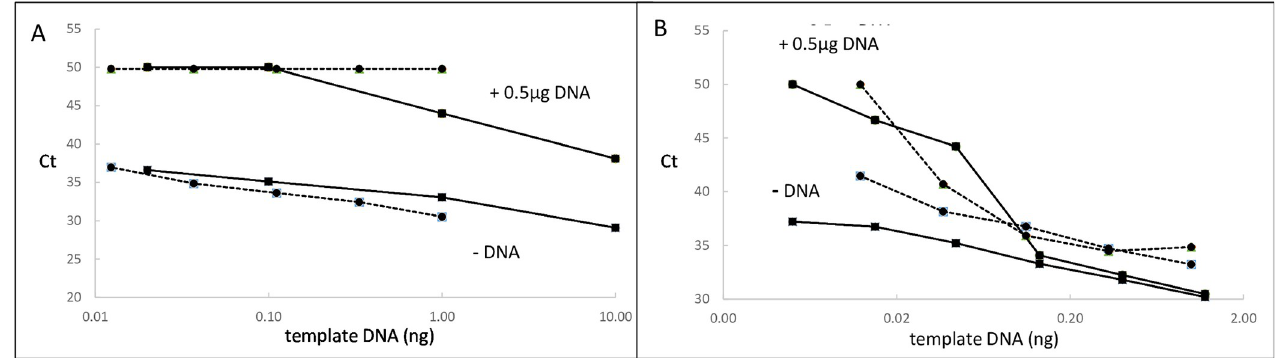
Fig 1. Inhibition of the PCR by genomic DNA. The primers were amplifying their target sequence in various masses of template DNA. An additional 0.5 μ g of non-leukemic genomic DNA was or was not added to each well. In each panel, the 2 solid lines refer to one patient and the 2 broken lines refer to another patient. Panel A shows 2 examples of severe inhibition and panel B shows 2 examples of mild inhibition. A Ct of 50 indicates that the PCR failed and no signal was observed.